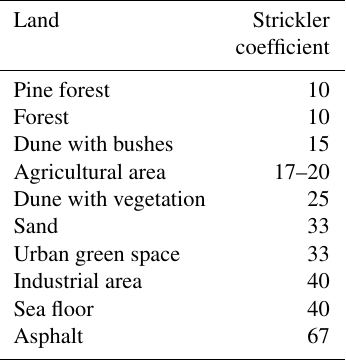
Table 3. Land types and Stickler coefficients used.